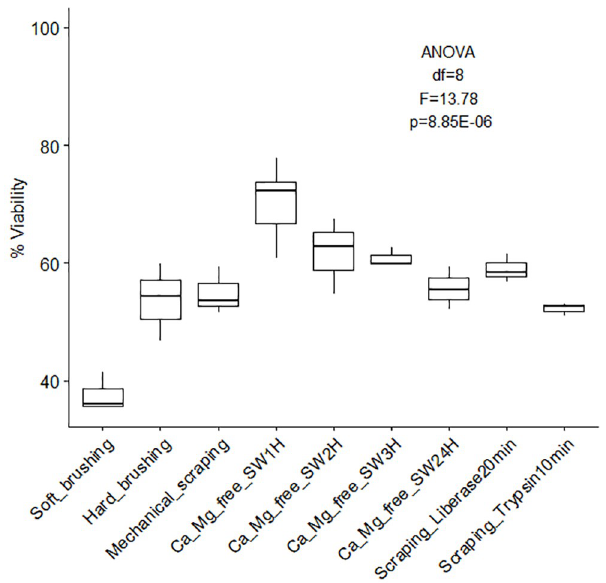
Fig 2. Overall cell viability (%) according to dissociation method. Percent viability ( ± SE) of cells dissociated from coral skeleton (immediately after dissociation) using different methods (soft/hard brushing, mechanical scraping, calcium-magnesium free seawater incubation for 1 to 24 hours, and enzyme digestion). S3 Table [ANOVA single factor: df = 8, F = 13.78, p = 8.85E-07].